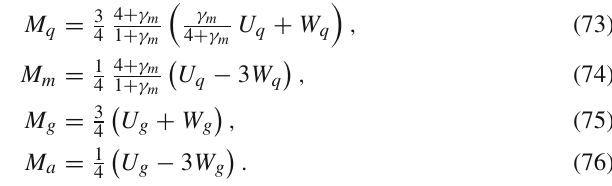
Fig. 3 Decomposition of the nucleon pressure–volume work within Ji’s picture (67) in units of M at the scale μ = 2 GeV